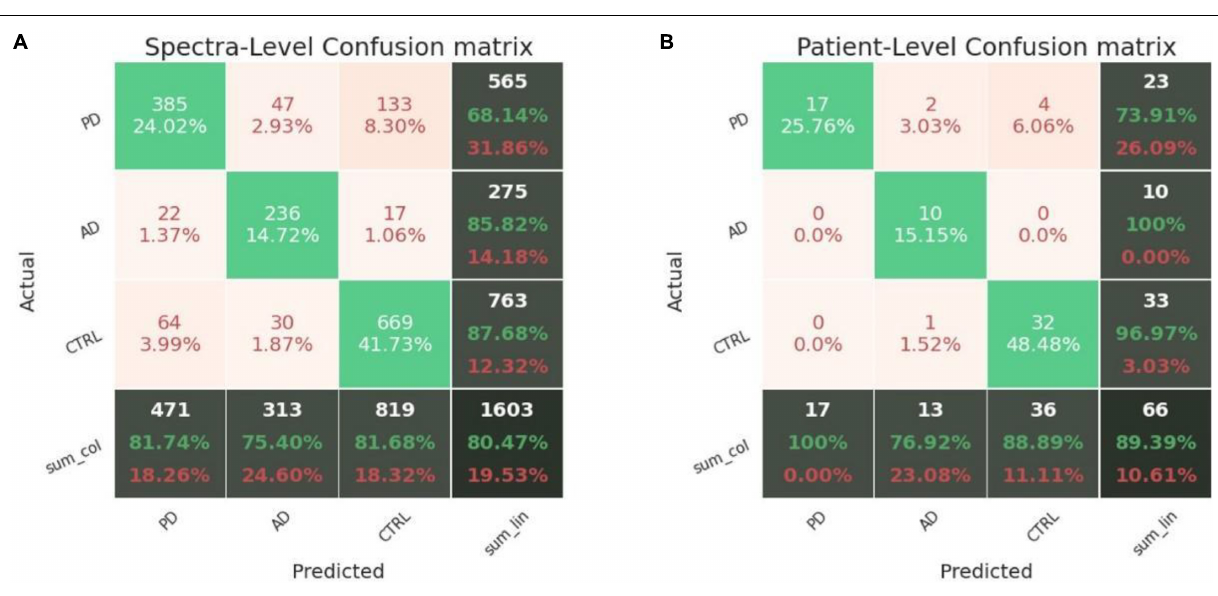
Figure 6 | Confusion matrices obtained in LOPOCV by the proposed CNN. (A) Spectra-level and (B)